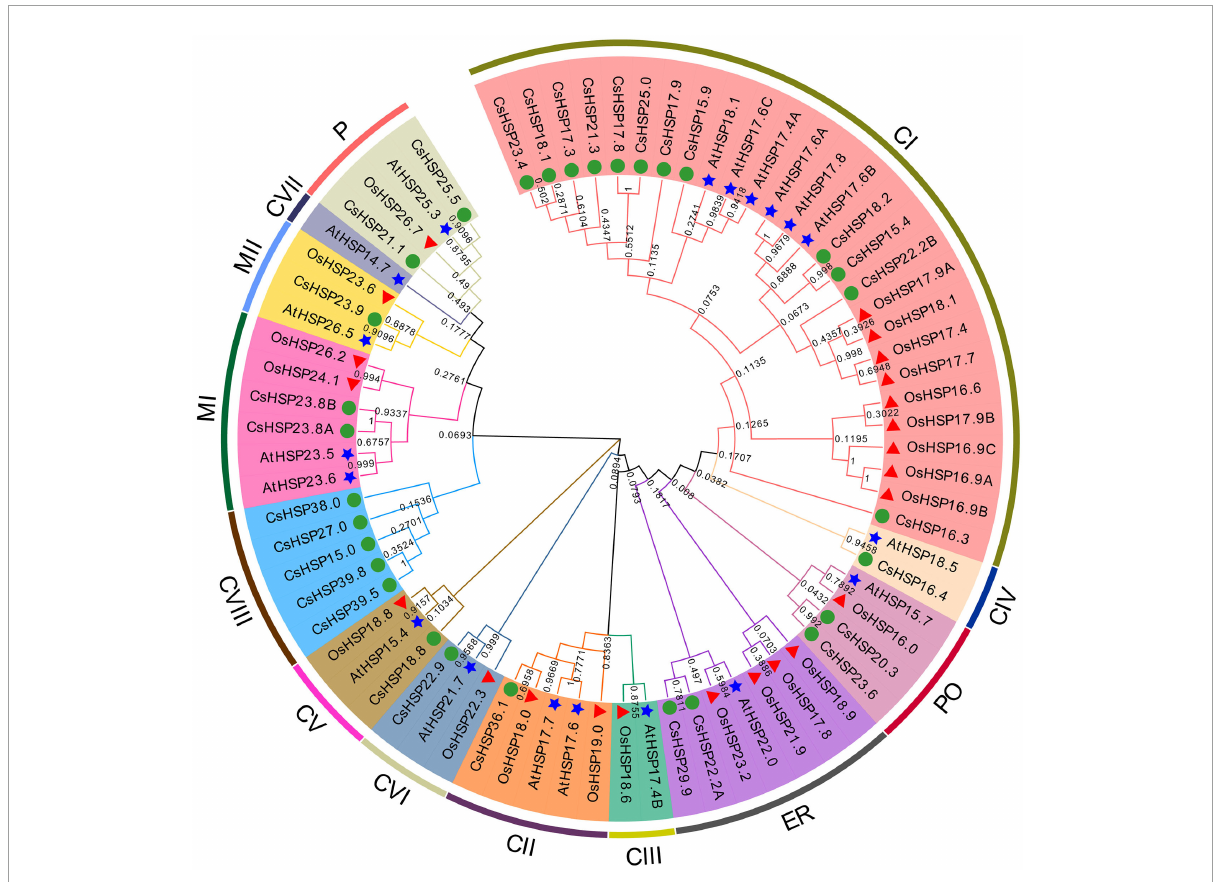
FIGURE3 Phylogenetic tree of the total HSP20 proteins from cucumber, Arabidopsis (19 AtHSP20), and rice (23 OsHSP20). The NJ phylogenetic tree was constructed by MEGA-X with default parameters and bootstrap test of 1000 times. The arcs marked with distinct color represent different subgroups of HSP20 proteins. The green circle, red triangle, and blue star represent HSP20 from cucumber, rice, and Arabidopsis ,